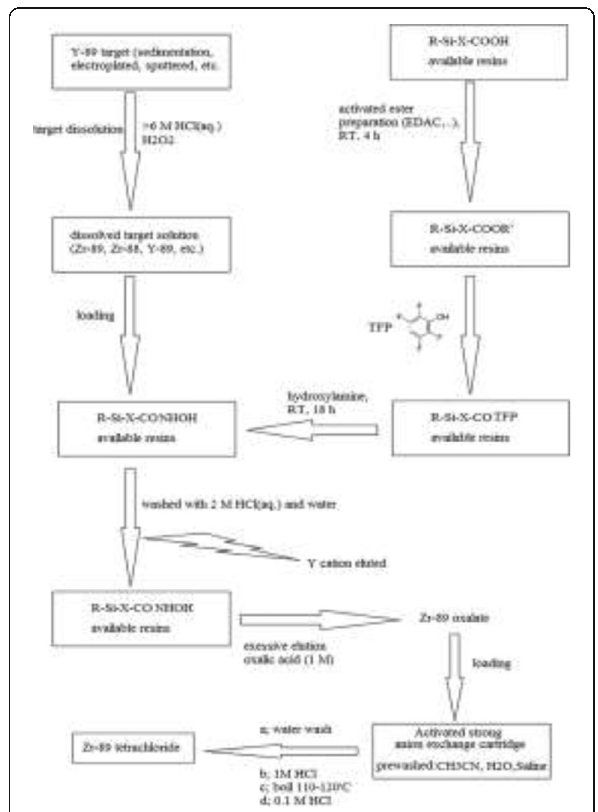
Fig. 1 (abstract PP10). See text for description